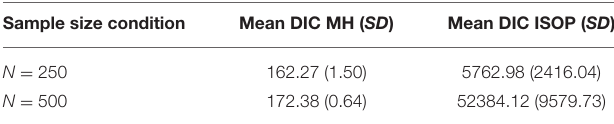
TABLE 2 | Mean and (Standard Deviations) of the DIC statistic for the MH and ISOP model under different sample size conditions with Rasch-fitting